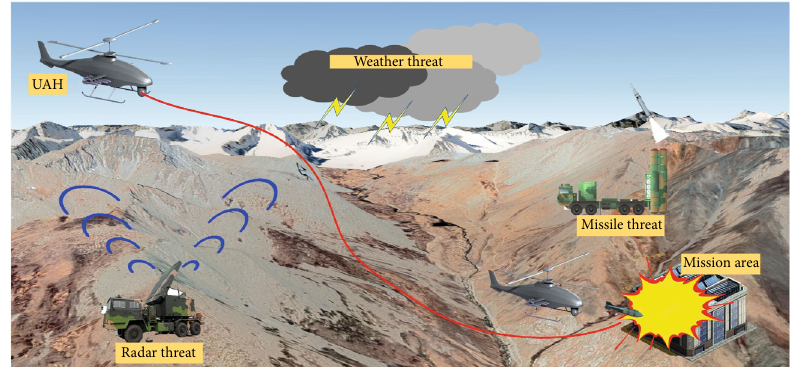
Figure 1: Schematic of UAH path planning mission.